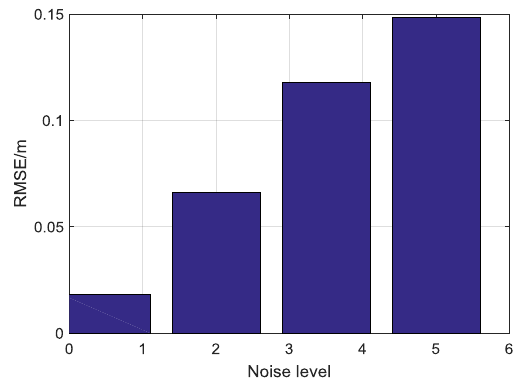
Figure 9. RMSE of 3D reconstruction proposed in this paper after 500 Monta-Carlo experiments.